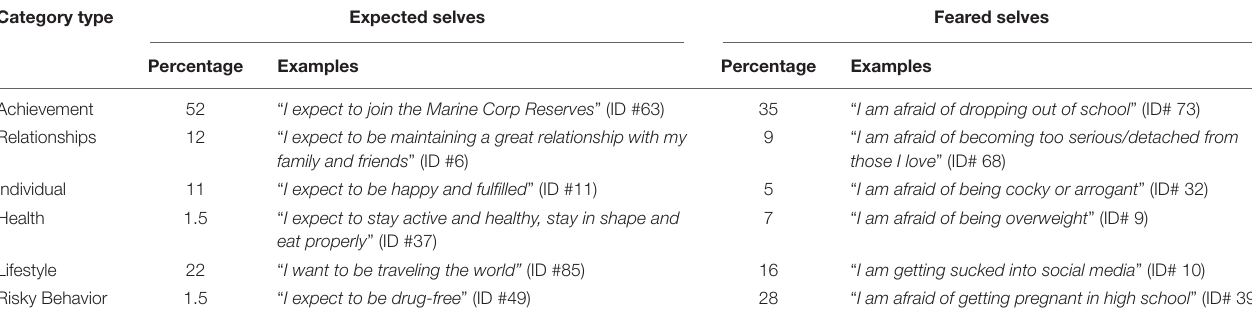
TABLE 2 | Types of possible selves by categories.